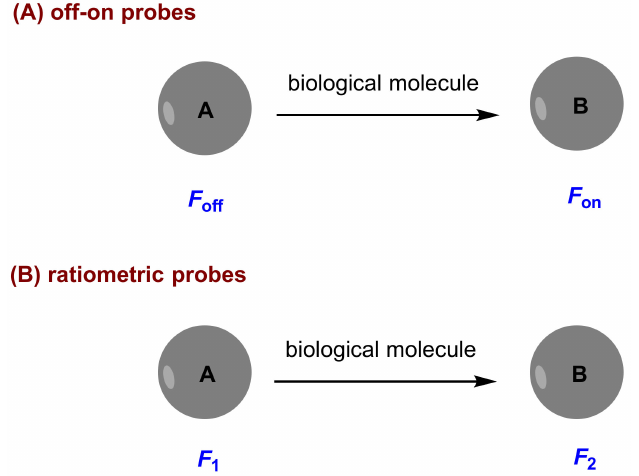
Figure 1. Schematic representation of fluorescent off-on probes and ratiometric probes in this